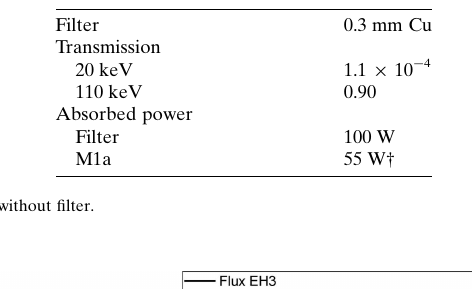
Table 2 Filter transmissions and absorbed powers for the 110 keV DMM with an incident power of 156 W.